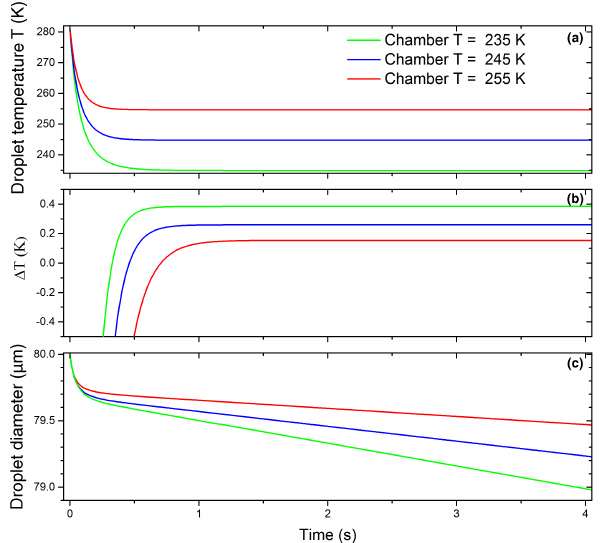
Figure 1. Droplet characteristics at experimental conditions cal- culated along the pathway through the chamber with time steps of 0.01s. Panel (a) shows the surface temperature of the droplet, (b) shows the difference between the surface temperature of the droplet and the chamber temperature and (c) shows the droplet di- ameter at chamber temperatures of 235, 245 and 255K. These pa- rameters are calculated using Eqs. (13)–(15b) of Pruppacher and Klett (1997).